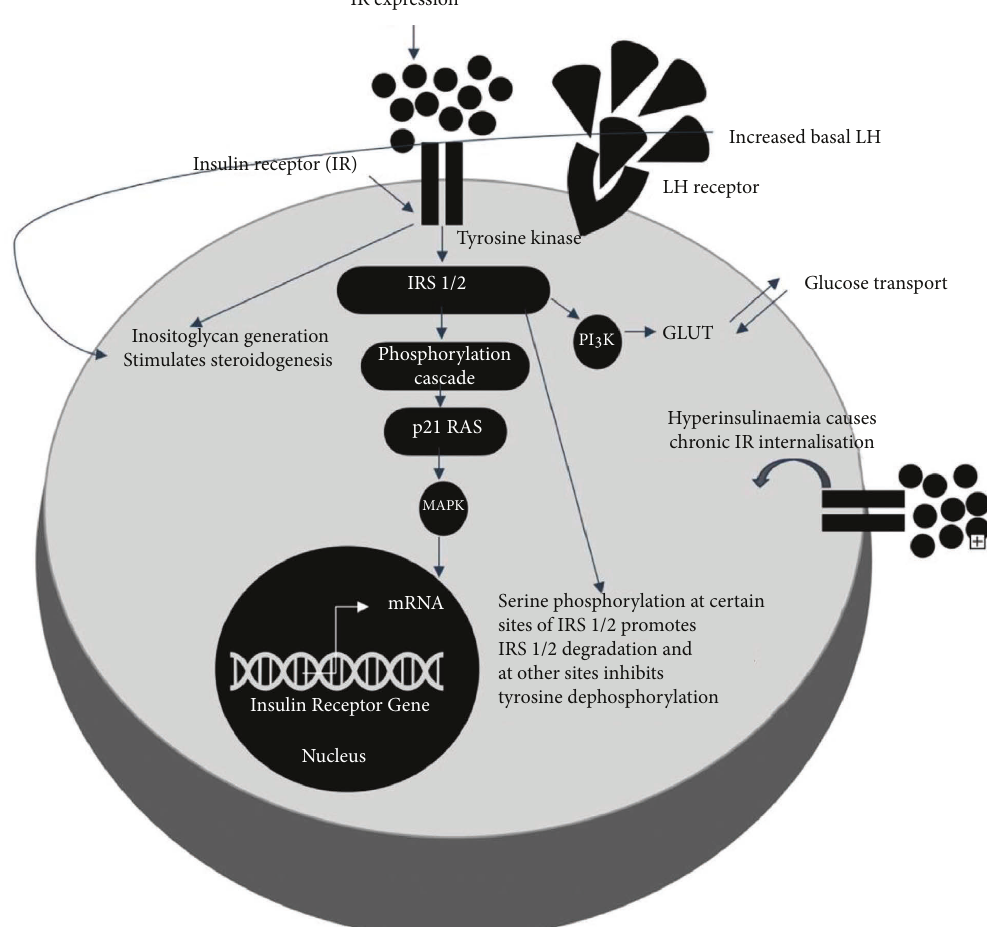
Figure 3: Illustration of the effect of hyperinsulinemia on insulin receptors and stimulation of steroidogenesis caused by hyperinsulinemia and increased LH (luteinizing hormone) levels. Insulin receptor defects are due to serine phosphorylation of the insulin receptor and IRS-1 (insulin receptor substrate 1) secondary to intracellular serine kinases. This results in reduced PI3K (phosphoinositide 3-kinase) downstream activity after insulin mediated activation and resistance to the metabolic actions of insulin. Activation of kinases in ERK/MAPK (extracellular signal-regulated kinases/mitogen-activated protein kinases) mitogenic pathway in PCOS (polycystic ovarian syndrome) causes inhibitory serine phosphorylation of IRS-1 in skeletal muscle in patients with PCOS as demonstrated here. These defects in the insulin receptor gene exist in patients with PCOS with extreme insulin resistance although insulin receptor numbers and affinity are similar to those in the patient without insulin receptor defects. Steroidogenesis is stimulated by both hyperinsulinemia causing inositolglycan generation and increased basal LH secreted from the anterior pituitary in response, also demonstrated